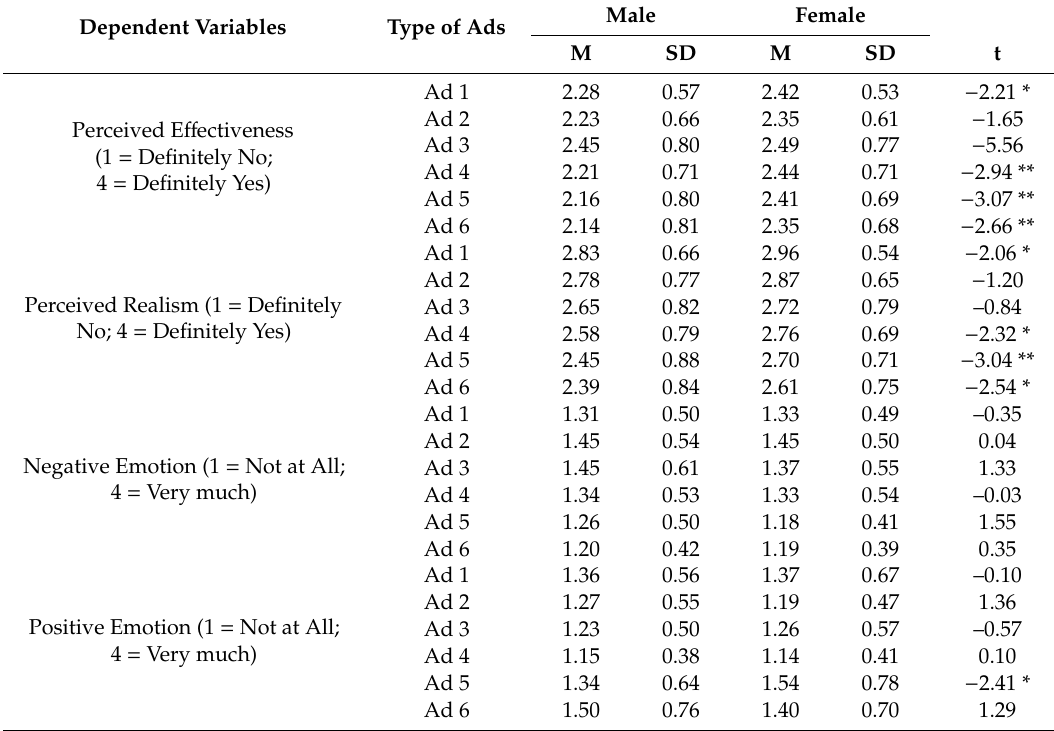
Table 2. Results of t tests and descriptive statistics by